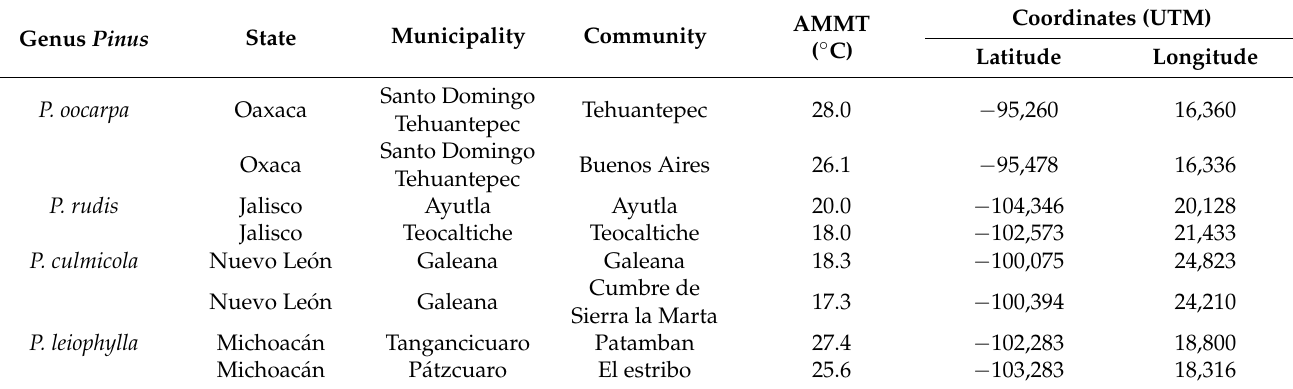
Table 3. Collection locations for seeds from populations of the genus Pinus .